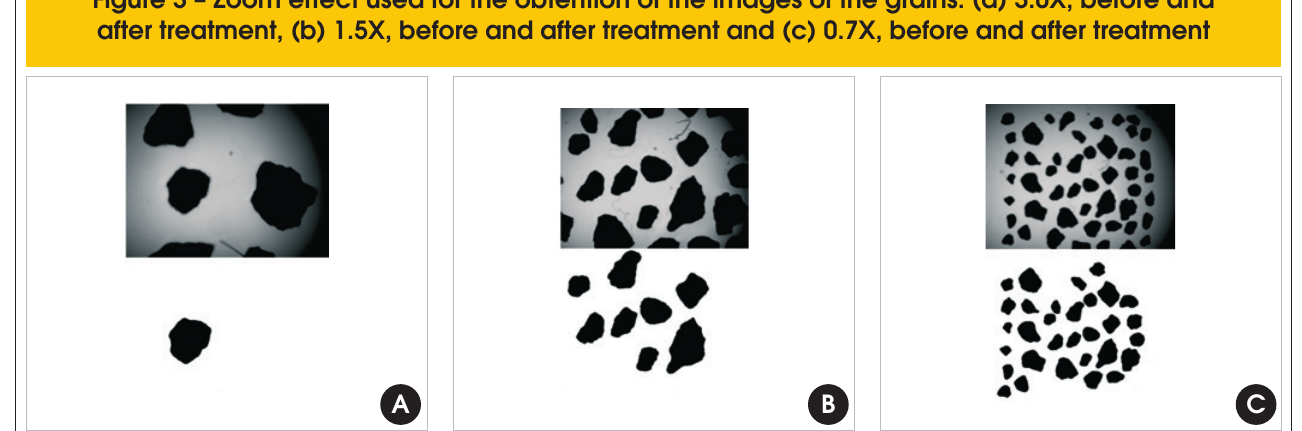
Figure 3 – Zoom effect used for the obtention of the images of the grains: (a) 3.0X, before